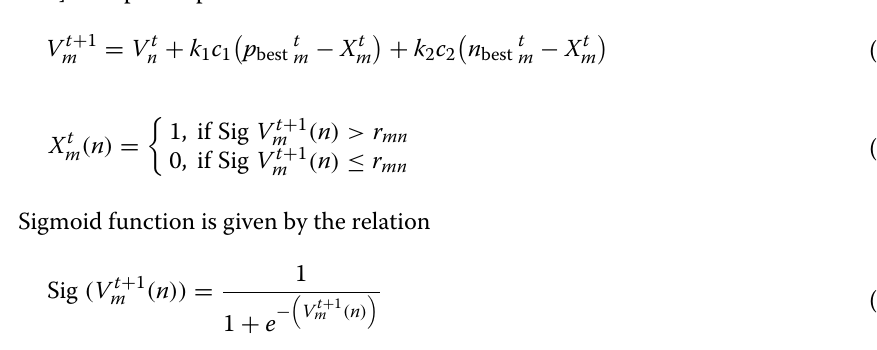
Method‑experimental setup for image segmentation Multilevel recursive discrete PSO for image